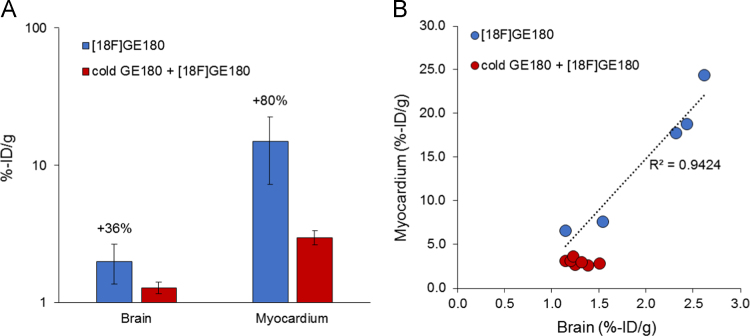
Gamma counter measurements of tracer uptake in brain and myocardium ex vivo. (A) Bar graphs (logarithmic scale) show %-injected dose-(ID)/g at 107 min after injection of [18F]GE180 with (red) and without (blue) prior blocking with excess non-radioactive GE180 (1000:1). Specific binding was estimated to be 36% in the brain and 80% in the myocardium. Absolute specific binding was 17-fold higher in the myocardium when compared to the brain. (B) Correlation between %-ID/g of brain and myocardium in single mice indicate a relationship between specific TSPO tracer binding in the two tissues, whereas nonspecific binding did not correlate (R2 < 0.2). Data derive from N = 5 unblocked and N = 7 blocked C57Bl/6 mice at seven months of age. Error bars indicate standard deviations. Single data points are available in the supplement.